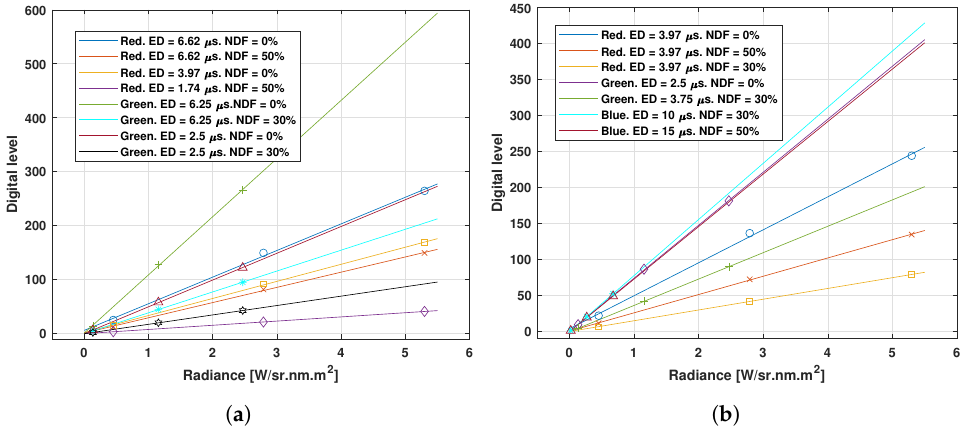
Figure 6. Calibration curves. ( a ) Dynamic range comparison. ( b ) Interference filter